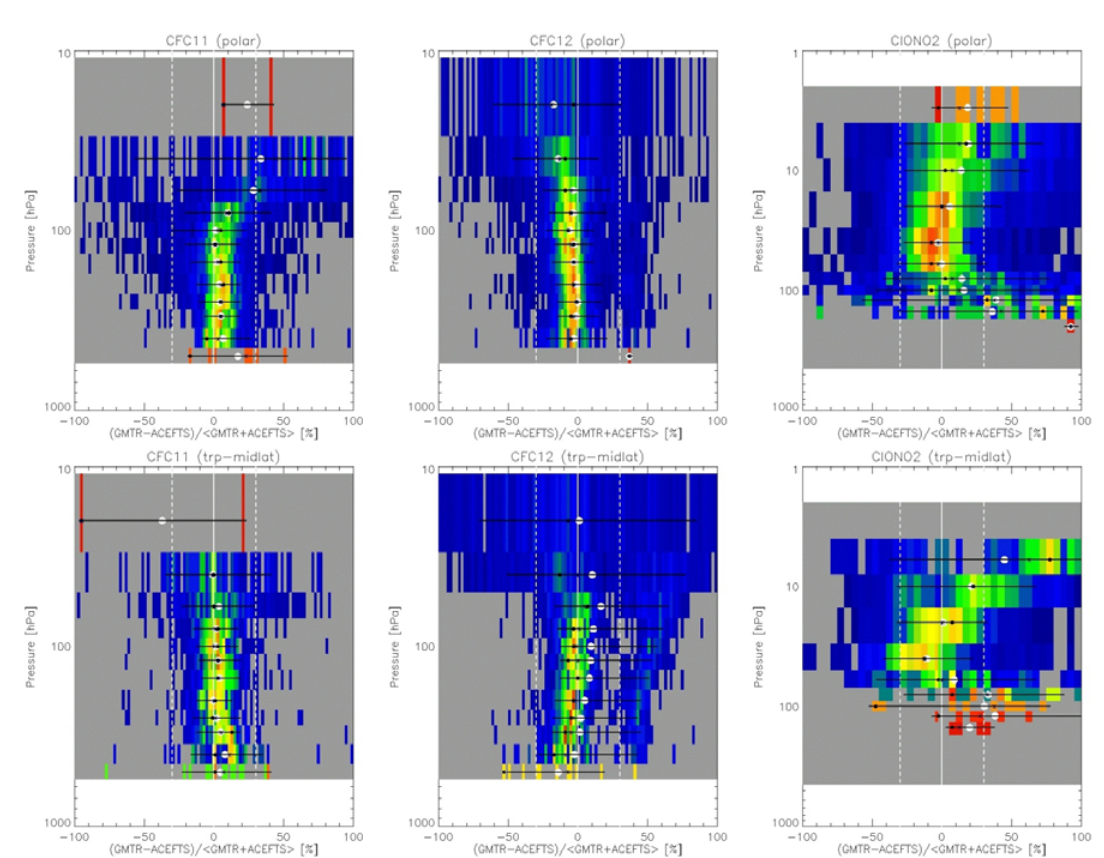
Figure 2. From left to right: CFC-11, CFC-12, ClONO 2 MIPAS2D-ACE differences computed as (1) for polar (top) and trp-midlat (bottom) regions. In each panel the distribution of the differences is indicated using white circles (mean), star symbols (median), and black dots (mode). The horizontal black lines indicate the 80% percentile. The colour (arbitrary) scale indicates the number density of samples having same difference values for each pressure layer from blue to red in increasing order (grey = no